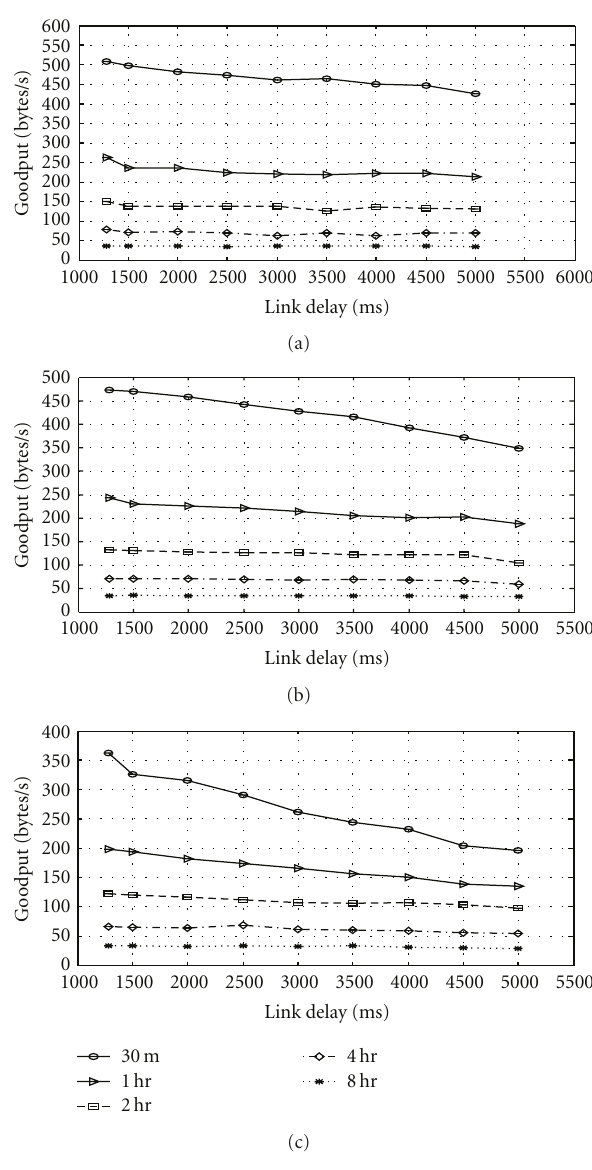
Figure 1: Goodput of DTN transmissions over cislunar channels with link disruption at di ff erent BERs. (a) BER = 0. (b) BER = 10 − 6 . (c) BER = 10 − 5